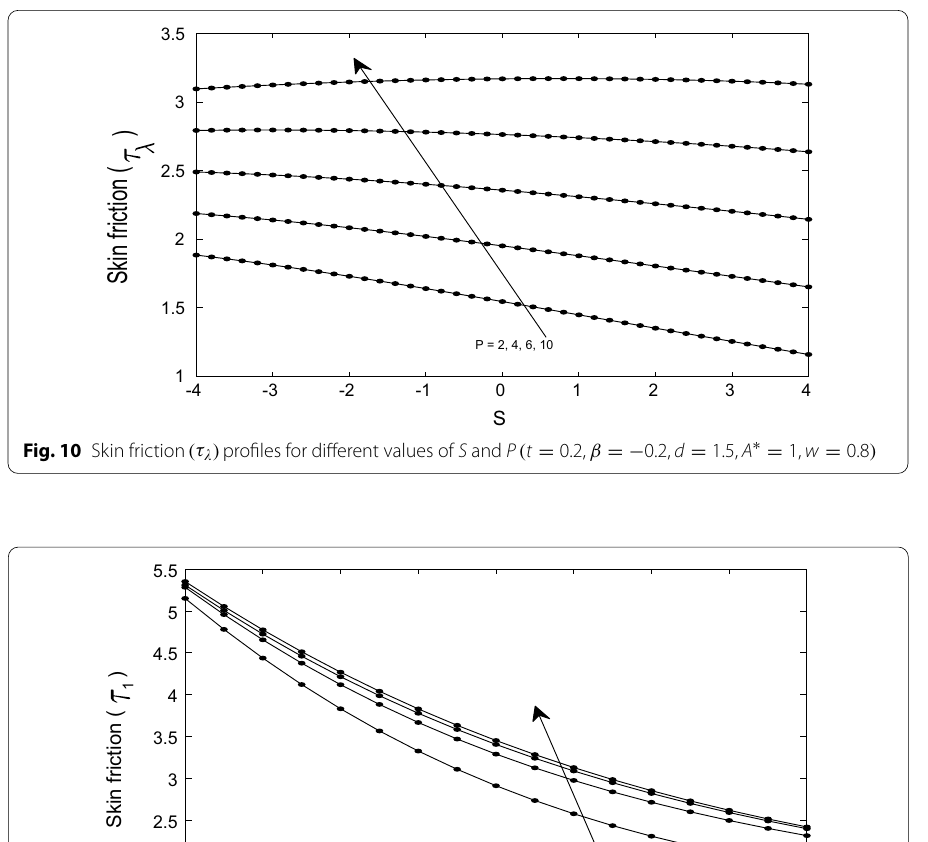
Fig. 11 Skin friction (τ 1 ) profiles for different values of S and d ( t